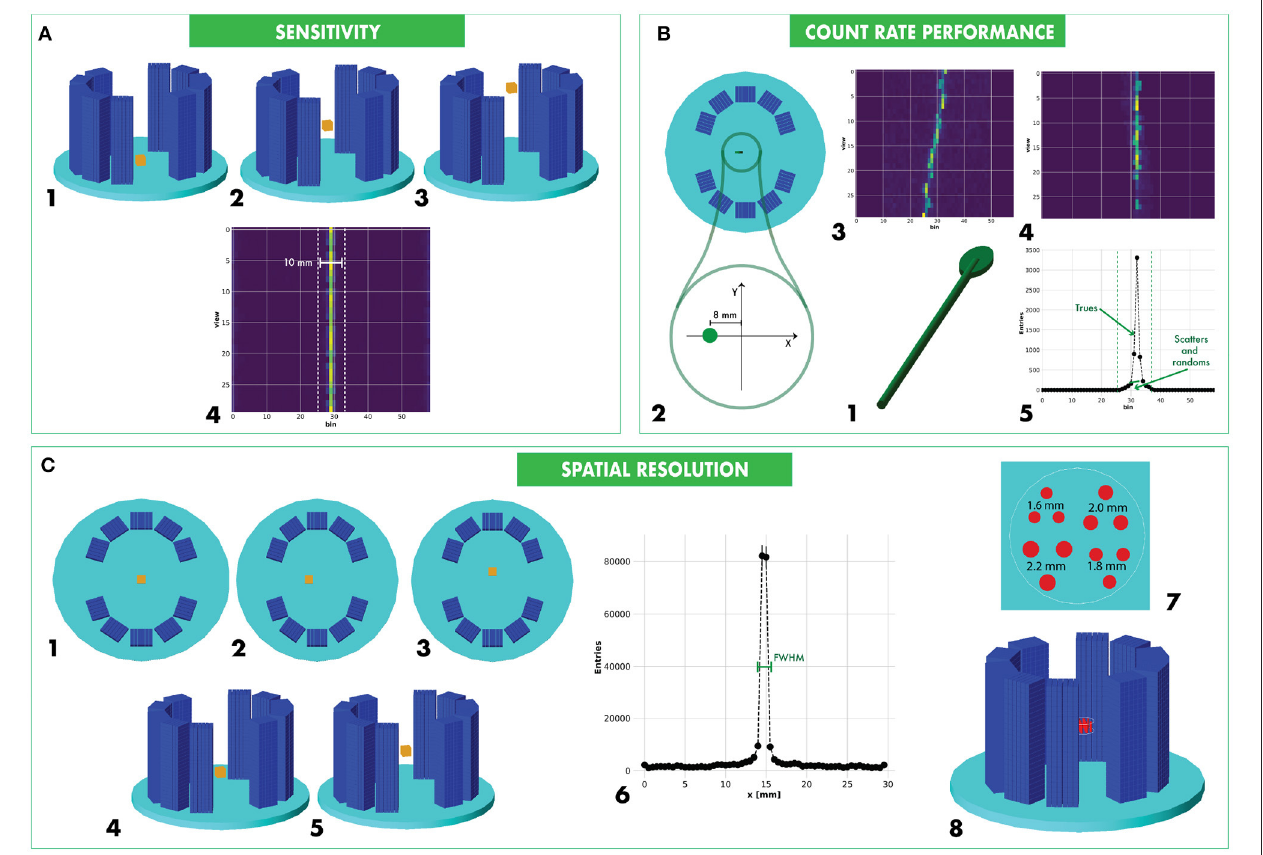
FIGURE 3 | Modified NEMA standards for Plant PET characterization: measurement of the sensitivity (A) , count rate performance (B) , and spatial resolution (C) .